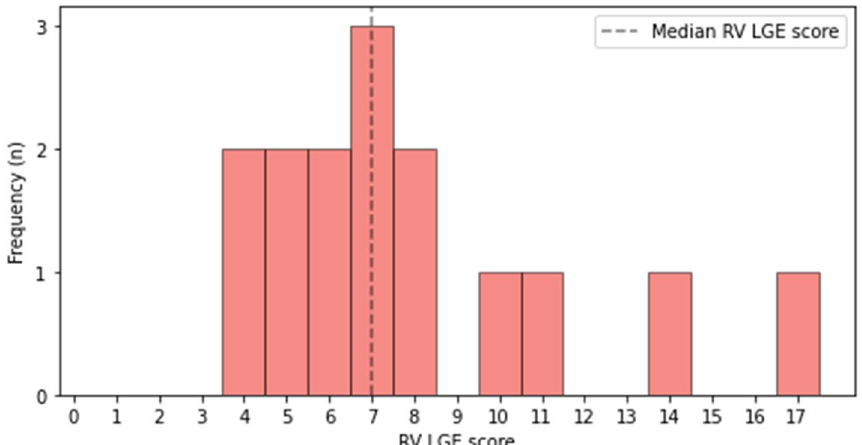
Fig. 2 Distribution of the right ventricular (RV) late gadolinium enhancement (LGE) score as proposed by Babu-Narayan et al. [9] among the study